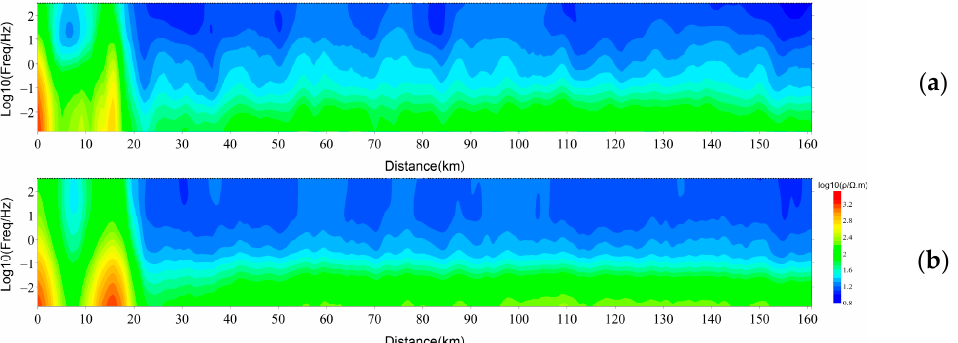
Figure 14. Apparent-resistivity sections of measured data ( a ) and calculated data from con- strained-inversion result for TM mode ( b ).